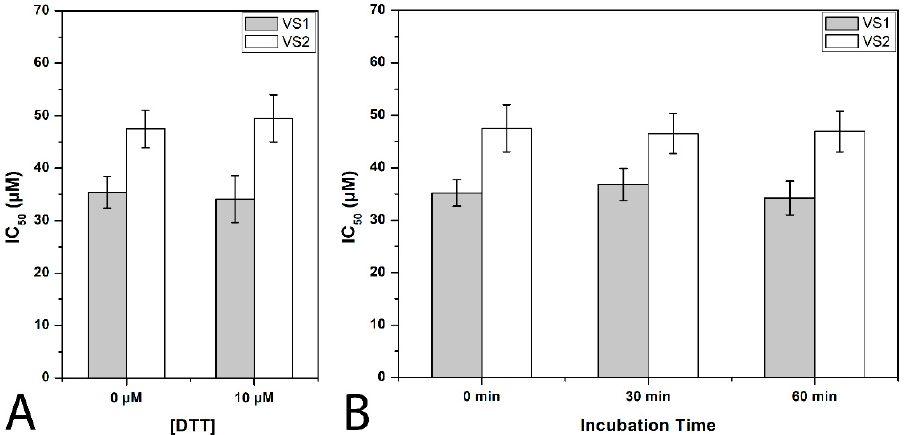
Figure 5. Compound VS1 - and VS2 -MAGL inhibition analysis. ( A ) Effect of DTT on MAGL inhibition activity. ( B ) IC 50 (µM) values of VS1 and VS2 at different preincubation times with MAGL (0 min, 30 min and 60 min).